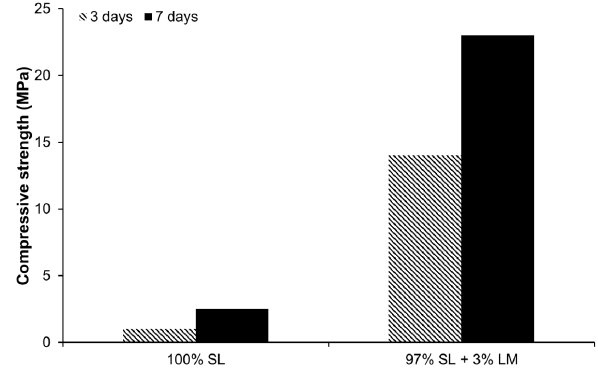
Figure 2: Effect of calcium hydroxide content on compressive strength (adapted from